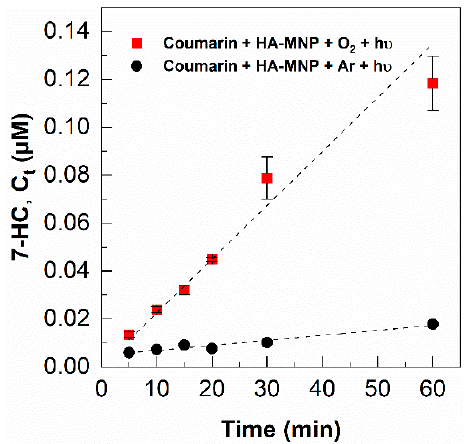
Figure 3. Formation of 7-HC in the presence of UVA and [HA-MNP] = 1.0 g L − 1 ; [Cou] 0 = 125 µM, oxygen-saturated ( ■ ) and argon-saturated ( ● ) environments; error bars represent the standard deviation of triplicate measurements.